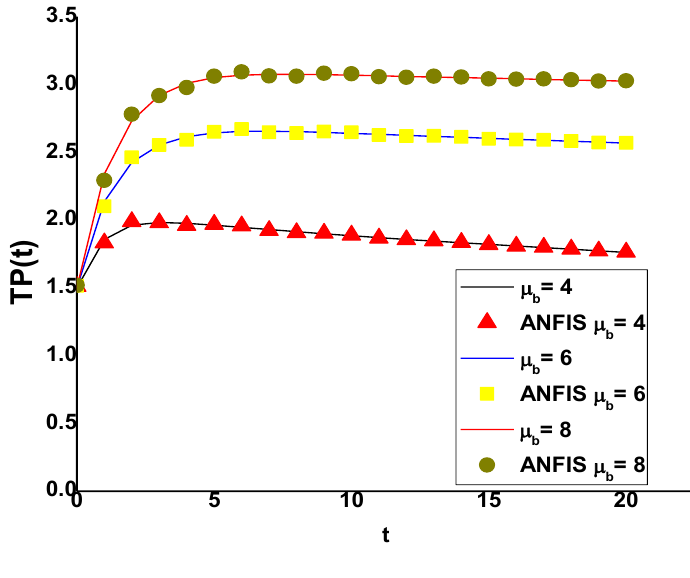
Figure 3. TP(t) vs t at various values of